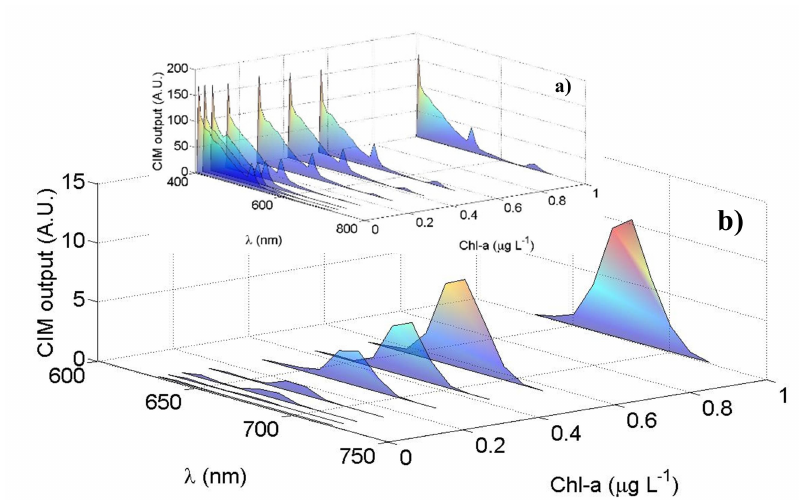
Figure 6. Laboratory test results: the PMT mean output signal (A.U.) as function of the wavelength (nm) for di ff erent Chl-a concentrations ( µ g L − 1 ): ( a ) the overall spectra between 405 nm and 720 nm; ( b ) the Chl-a peaks highlighted in the spectral region between 640 nm and 720 nm with their maxima at